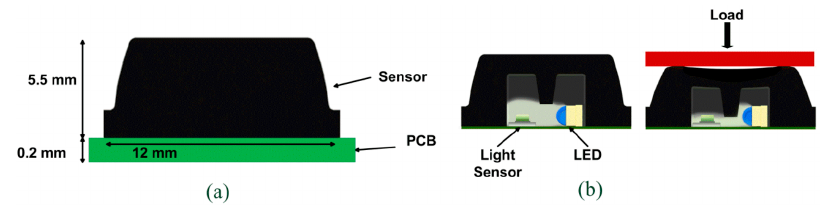
Figure 7. Optoelectronic pressure sensor for prosthetic applications [124].